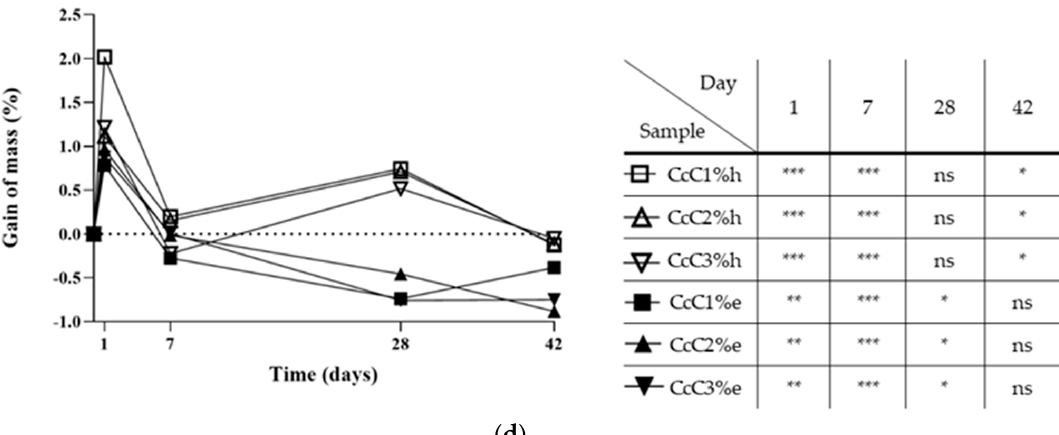
Figure 5. Enzymatic and hydrolytic degradation assay of the scaffolds developed for 42 days: ( a ) poly( ε -caprolactone) (PCL); ( b ) microcrystalline cellulose at 1, 2, and 3% (McC1%, McC2%, and McC3%, respectively); ( c ) methyl cellulose at 1, 2, and 3% (MC1%, MC2%, and MC3%, respectively); ( d ) and corncob cellulose at 1, 2, and 3% (CcC1%, CcC2%, and CcC3%, respectively). Hydrolytic samples are identified with an “h” and are graphically represented with an unfilled symbol ( ○ , □ , △ , ▽ ). Enzymatic samples are identified with an “e” and graphically represented with a symbol filled ( ● , ■ , ▲ , ▼ ). The assay was performed in triplicates, but only mean values are presented in the graphs. Statistically significant differences are presented as: * p < 0.05; ** p < 0.01; *** p < 0.001. ns refers to no statistically significant differences.